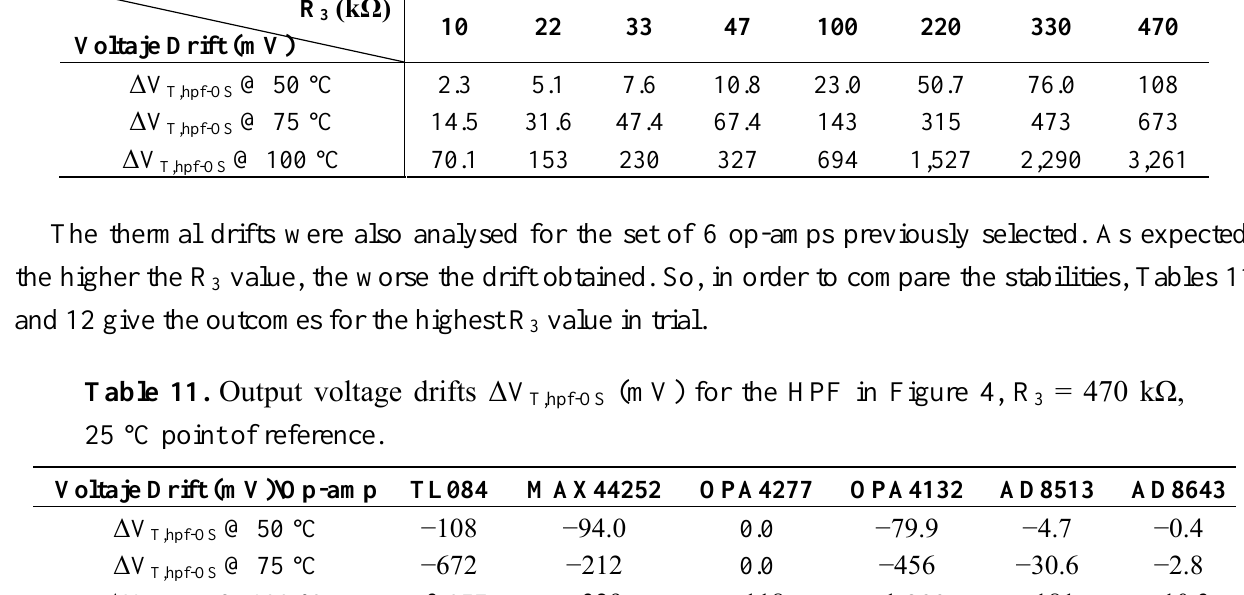
(mV) for the HPF in Figure 3, 25 °C point of reference. T,hpf-OS R (kΩ) 3